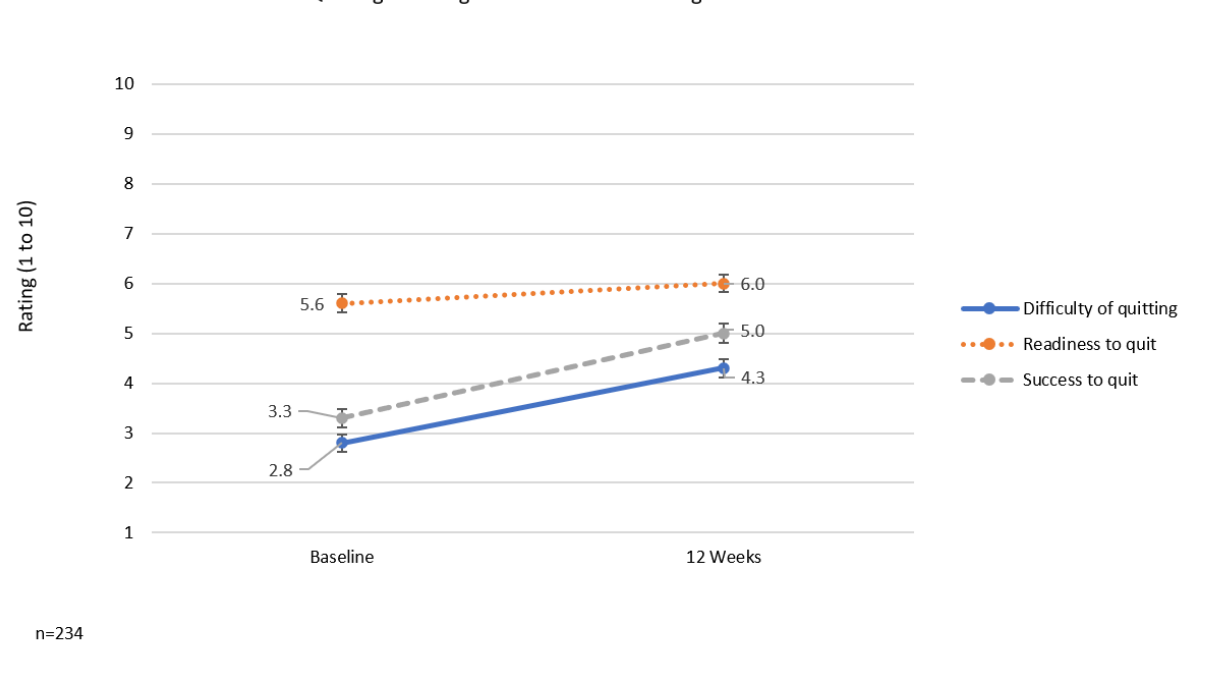
(Figure 4) at 12 weeks. Matched pair data are detailed in Table 6. Excluding the 4 participants who answered Other , 28.0% (59/211) strengthened their goal toward quitting, 55.0% (116/211) maintained their goal, and 17.1% (36/211) weakened their